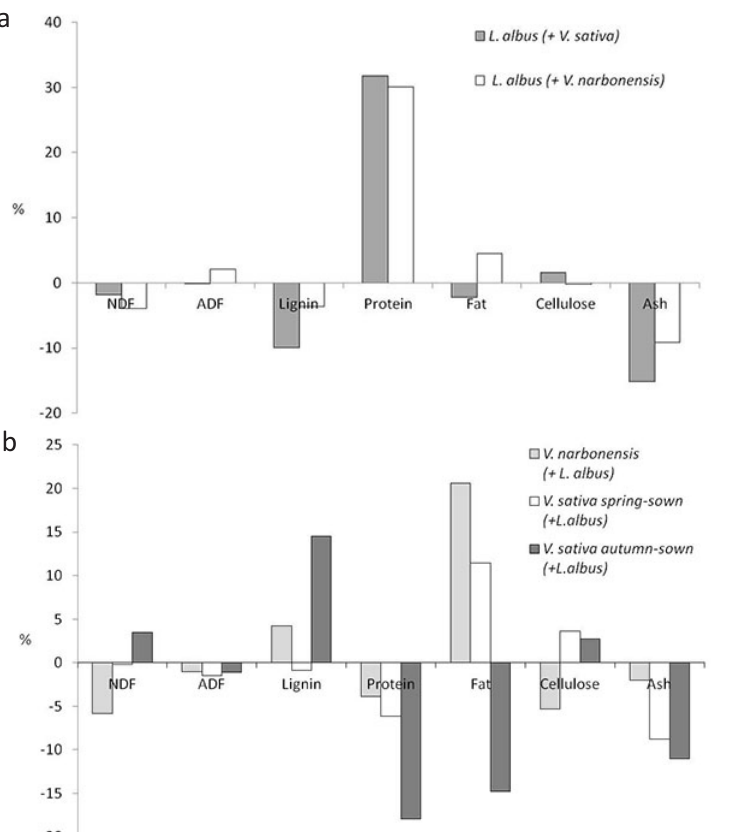
Fig. 5. Chemical composition of aboveground parts of intercropped plants expressed as a percentage of the values obtained for the control plants grown as sole stands. (a) L. albus ; (b) V. narbonensis , V. sativa spring-sown and V. sativa